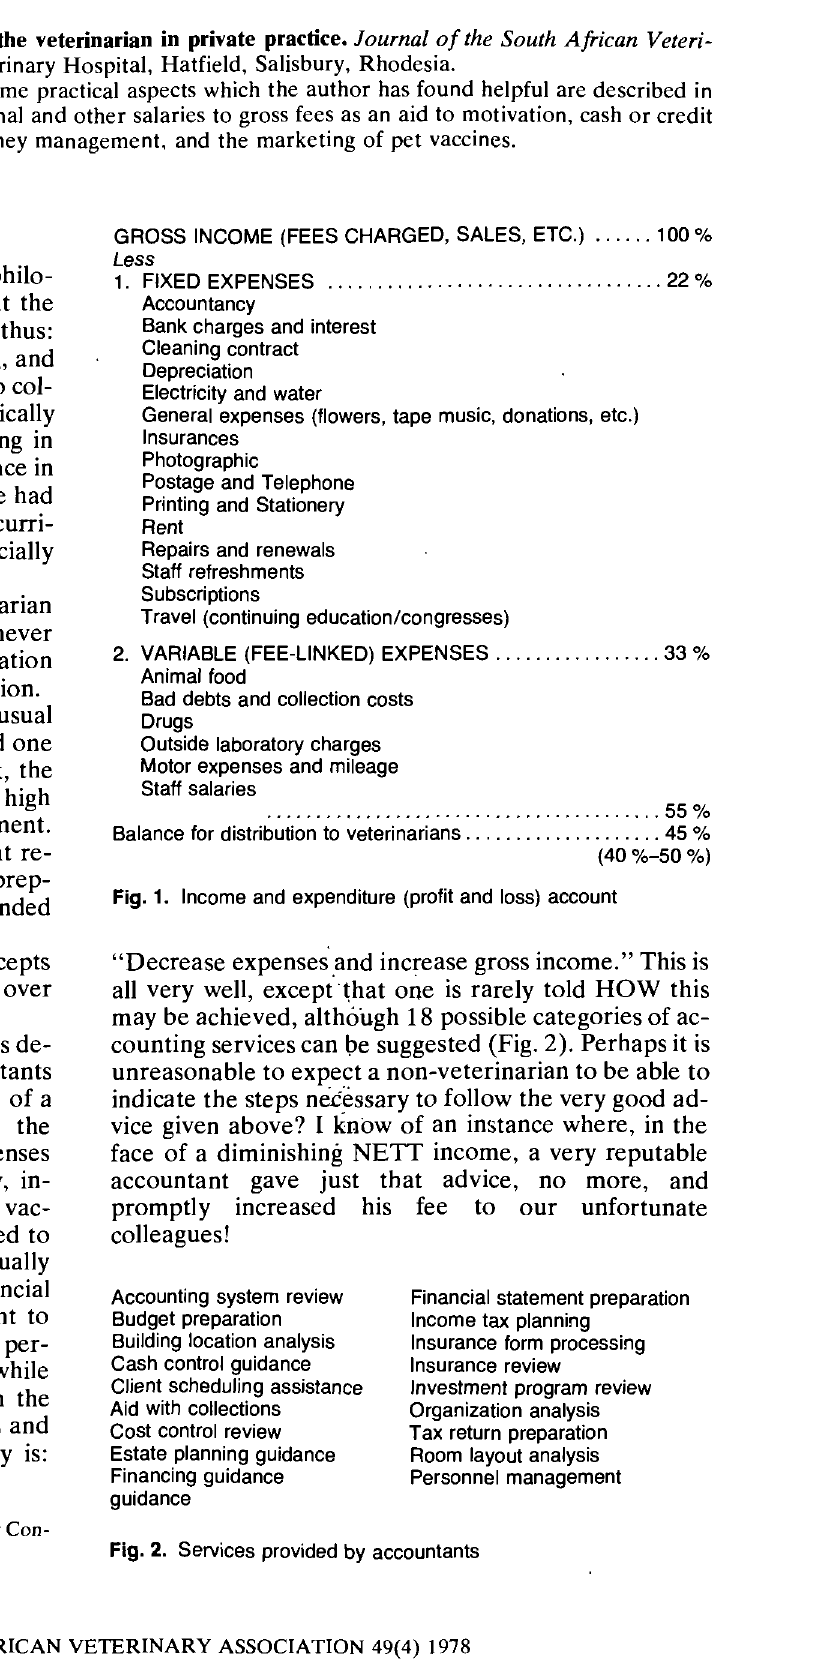
Fig. 1. Income and expenditure (profit and loss) account